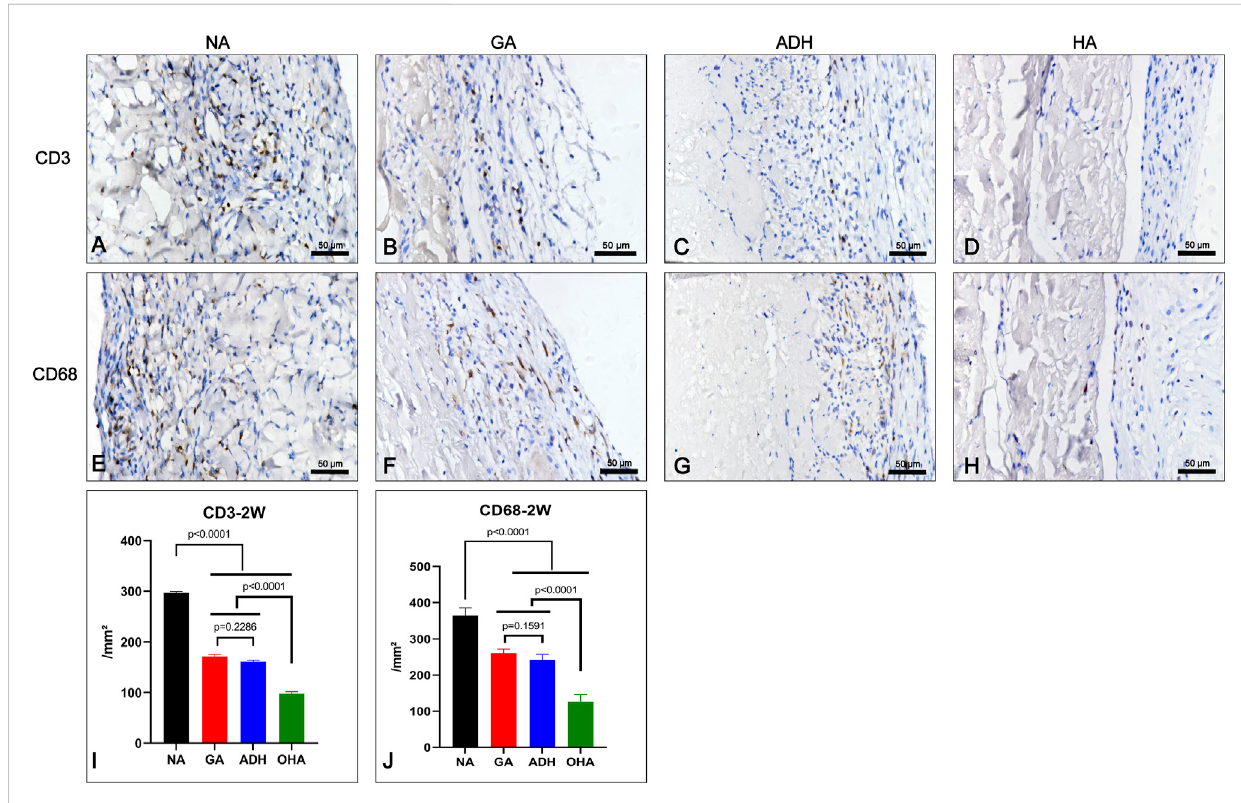
FIGURE 10 Characterization of the in fl ammatory response of the samples after subcutaneous implantation for 2 weeks. The images show the immunohistochemical staining of CD68 and CD3 in each group (A – H) and the corresponding quantitative analysis at 2 weeks (I, J)